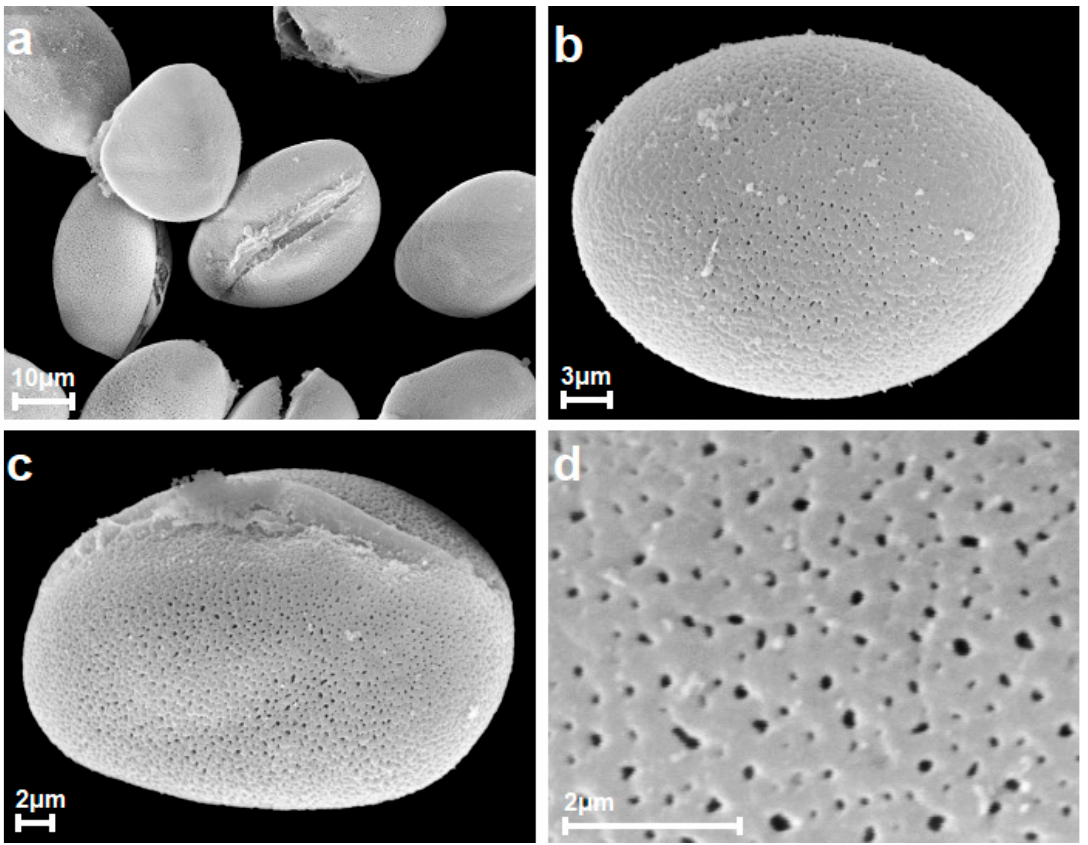
Figure 1. Pollen grains of Convallaria majalis; ( a ) group of pollen grains in the distal and proximal polar view with the sulcus seen in the center of one pollen grain, ( b ) proximal polar view, ( c ) equatorial view (long axis) and sulcus with membrane, ( d ) finely striate exine ornamentation with